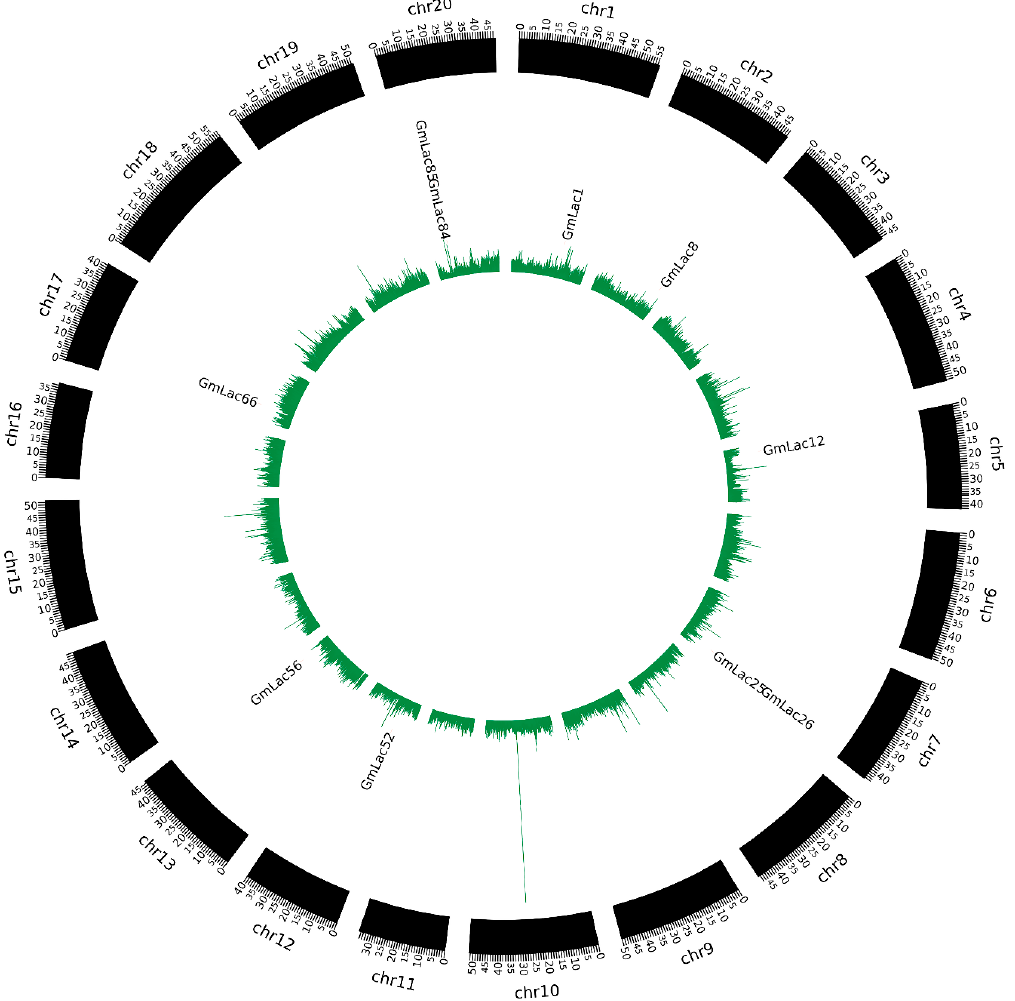
Figure 6. Selective pressure analysis of laccase gene family. The outermost scale represents chromosomes, and the green bar chart in the middle represents π G.max / π G.soja values per chromosome. The top 5% selected laccase genes are listed according to their physical location.